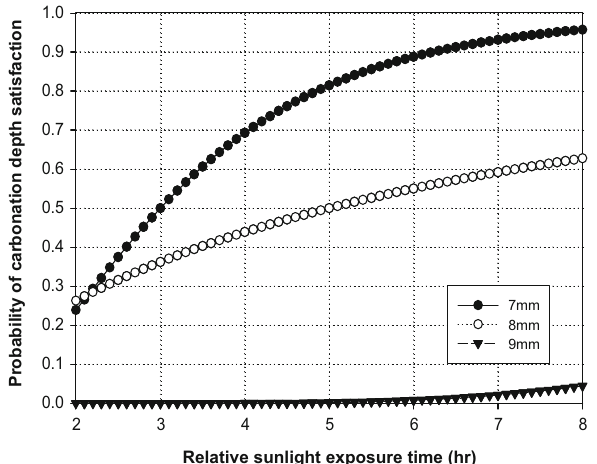
Fig. 10 Satisfaction Curve of wind speed parameter for carbonation rate (3.75).